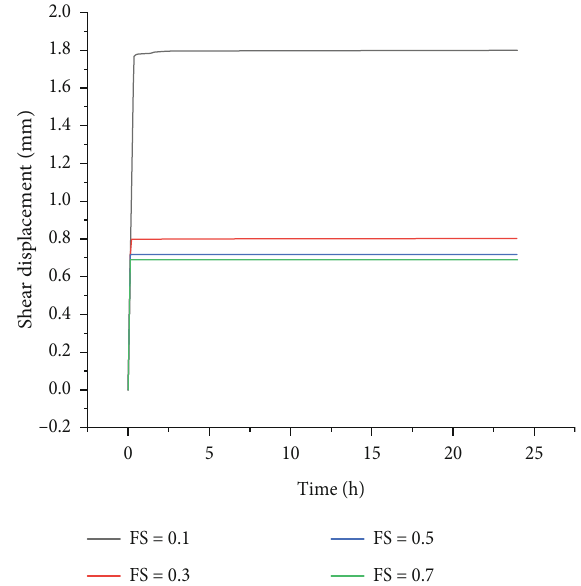
Figure 12: Shear displacement-time curves under di ff erent F conditions.